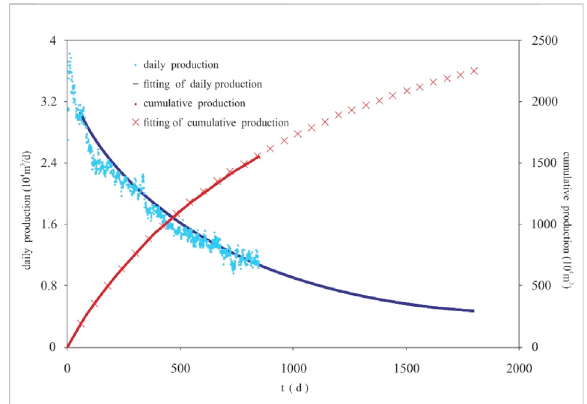
FIGURE 14 Historical fi tting curves of the production and cumulative production of the horizontal wells with class III reservoir quality.